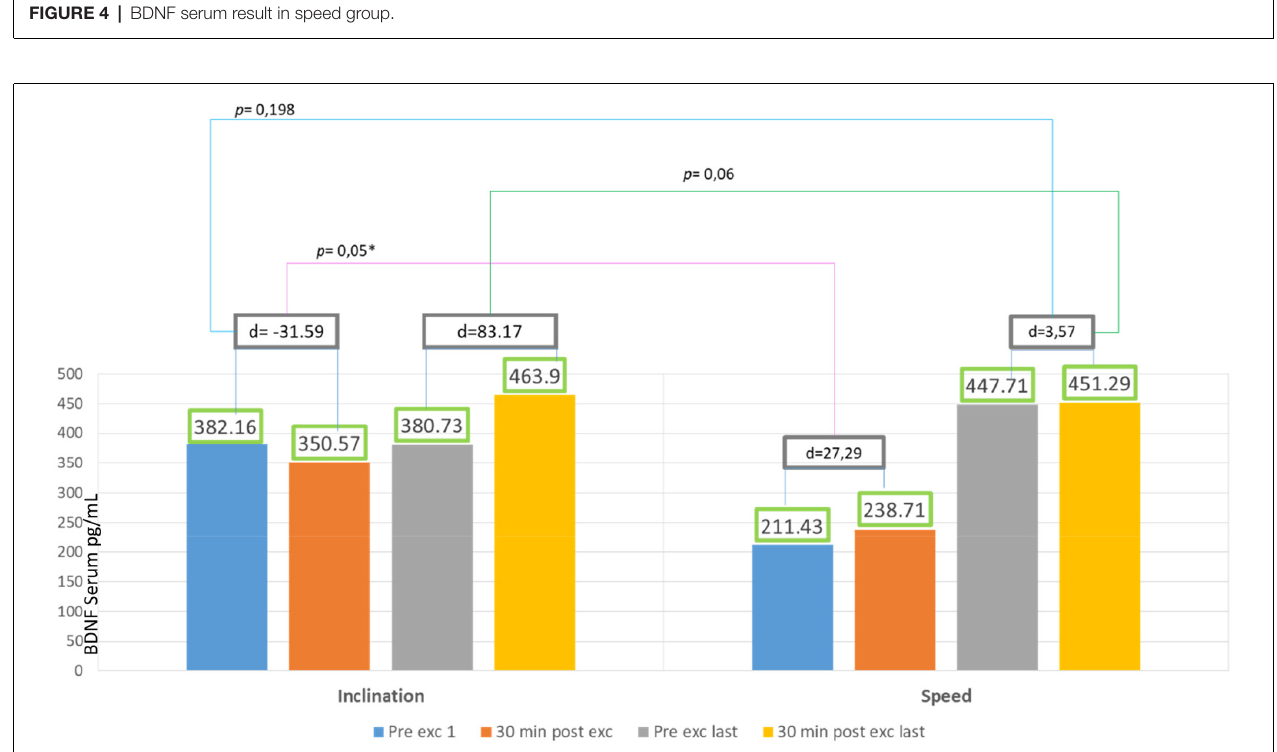
FIGURE 5 | The difference of BDNF serum result in speed and inclination group.